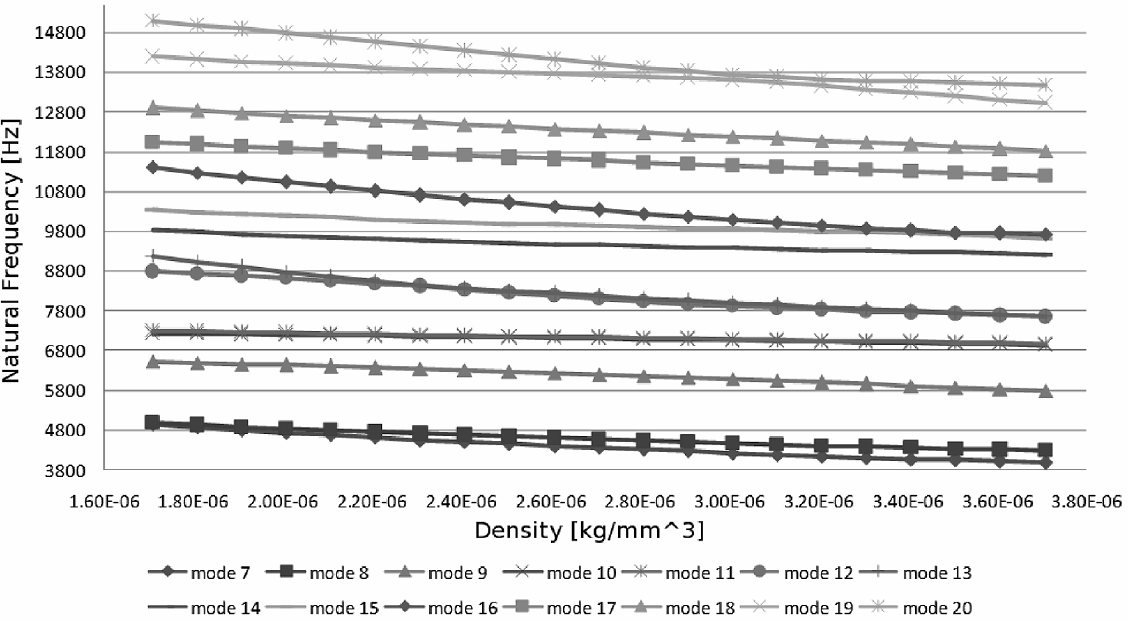
Fig. 9. Sensitivity of the caliper natural frequency to local density of aluminum